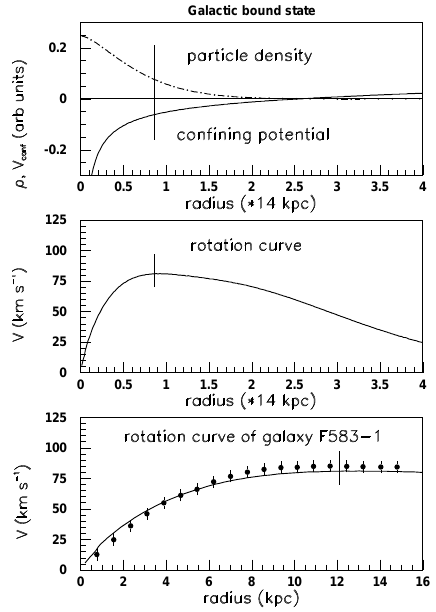
Fig. 3. Upper part: density (dot-dashed) and confining potential of a galactic bound state. Lower two parts: deduced velocity dis- tribution, with a radius fitted to that of the galaxy F583-1 shown in the lower part, which is compared to the data of ref.